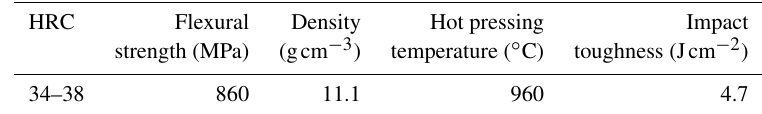
Table 1. Rock mechanical properties of rock samples. Rock Uniaxial compressive Tensile Shear Elastic Density Internal friction Poisson’s samples strength (MPa) strength (MPa) strength (MPa) modulus (GPa) (gcm − 3 ) angle ( ◦ ) ratio Sandstone 67.548 Limestone Granite